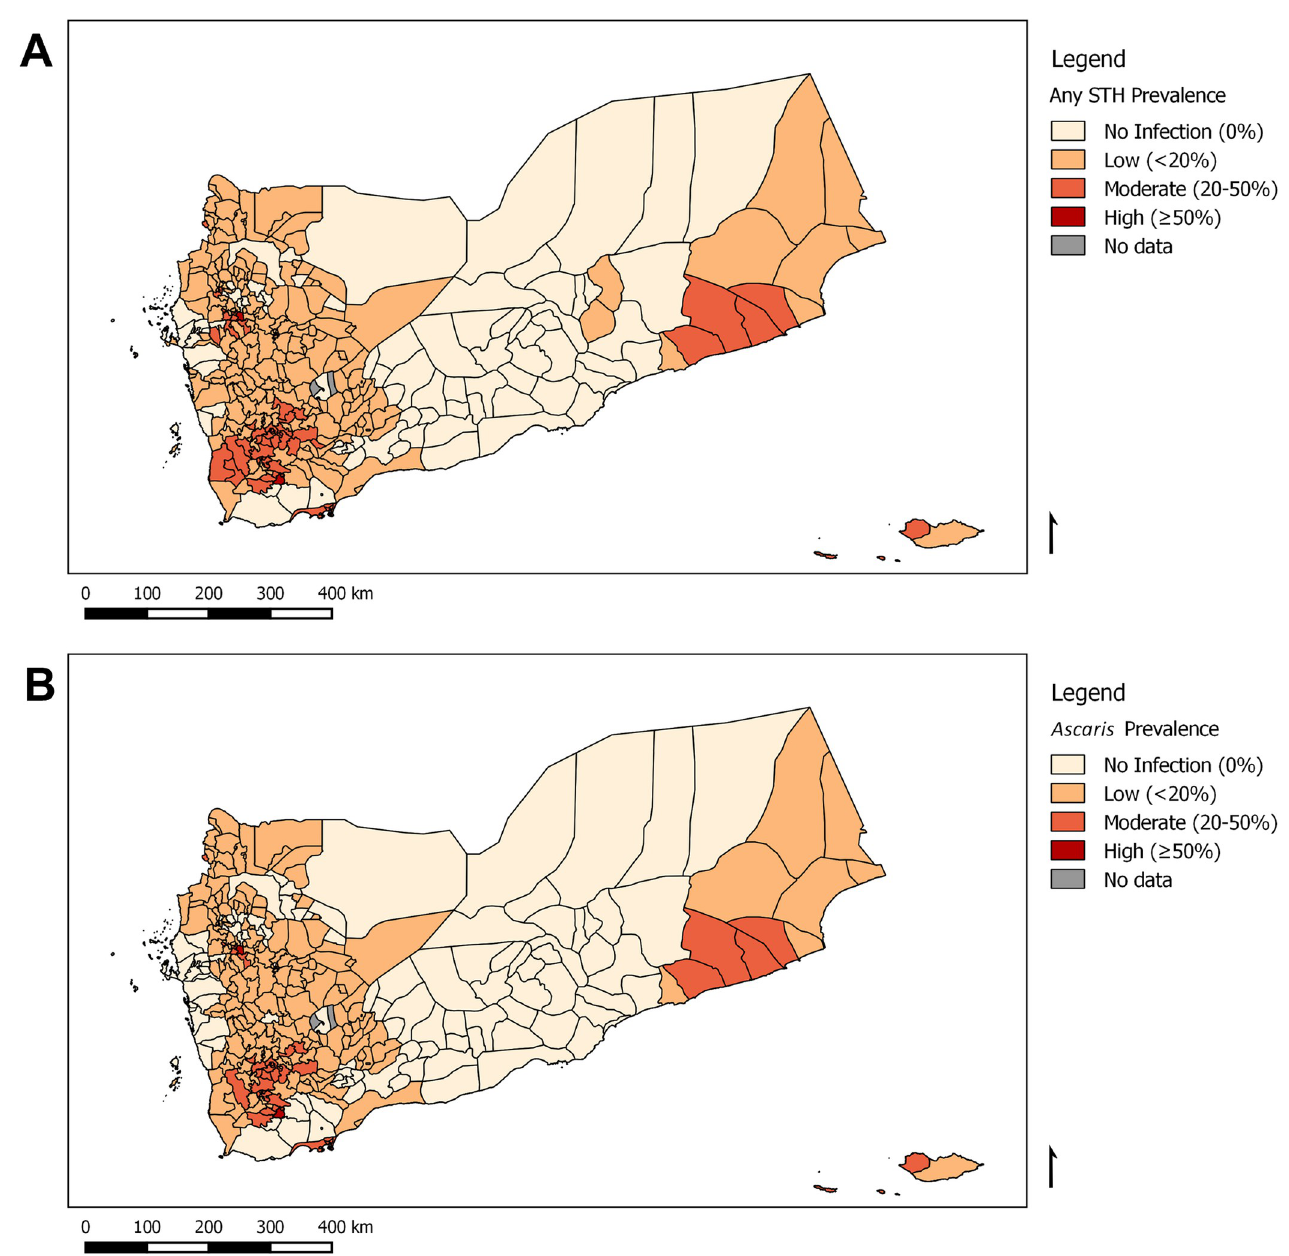
Fig 3. District-level point prevalence of soil-transmitted helminthaisis infection in Yemen, 2014. The maps depict (A) any soil-transmitted helminth infection and (B) Ascaris lumbricoides infection. These figures were created for this manuscript in QGIS using open source data from DIVA-GIS for the base layers.